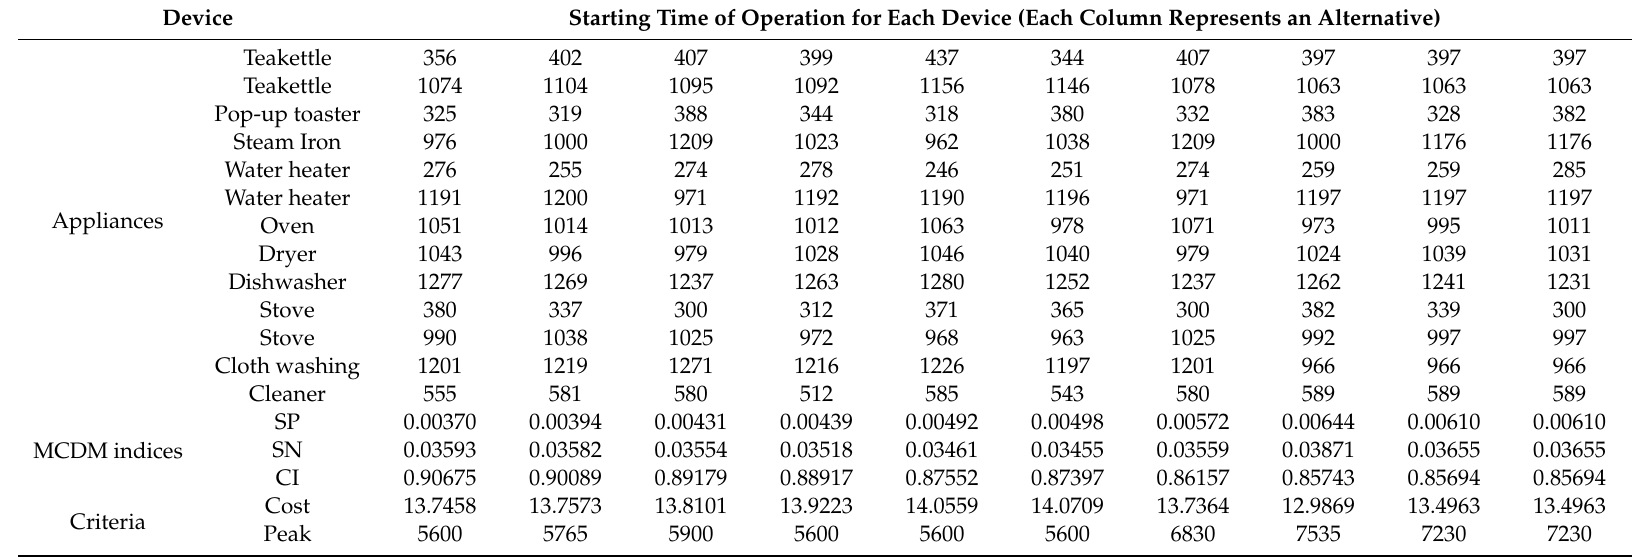
Table 9. Scores based on integrated AHP-TOPSIS for third